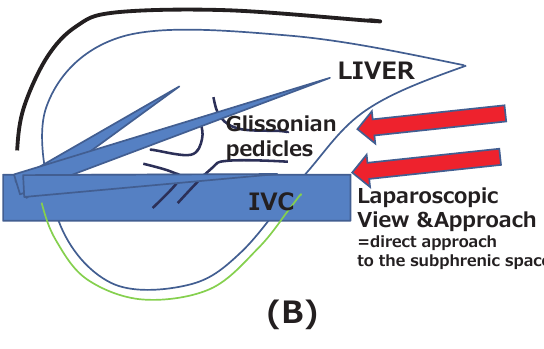
(A) In the open approach (red arrows), the subcostal cage containing the liver is opened with a large subcostal incision, and the costal arch is lifted with instruments (green arrow). The liver is dissected and mobilized (lifted) from the retro-peritoneum (yellow arrows).